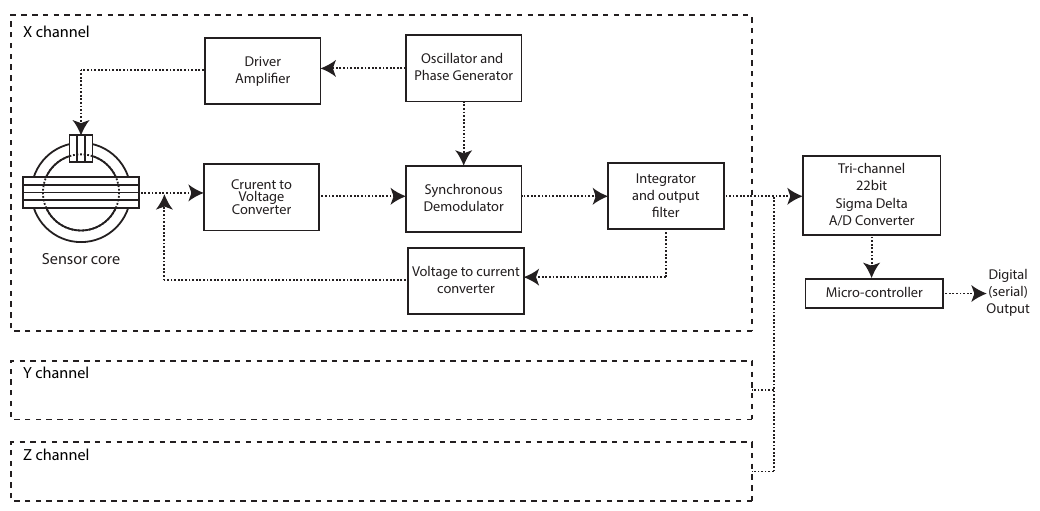
Figure 3. Complete magnetometer block diagram showing three channels and digital